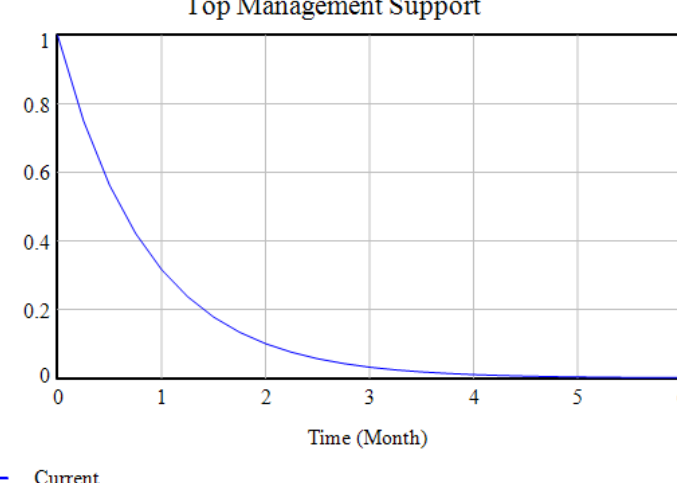
Figure 16. Simulation result of ‘Top Management